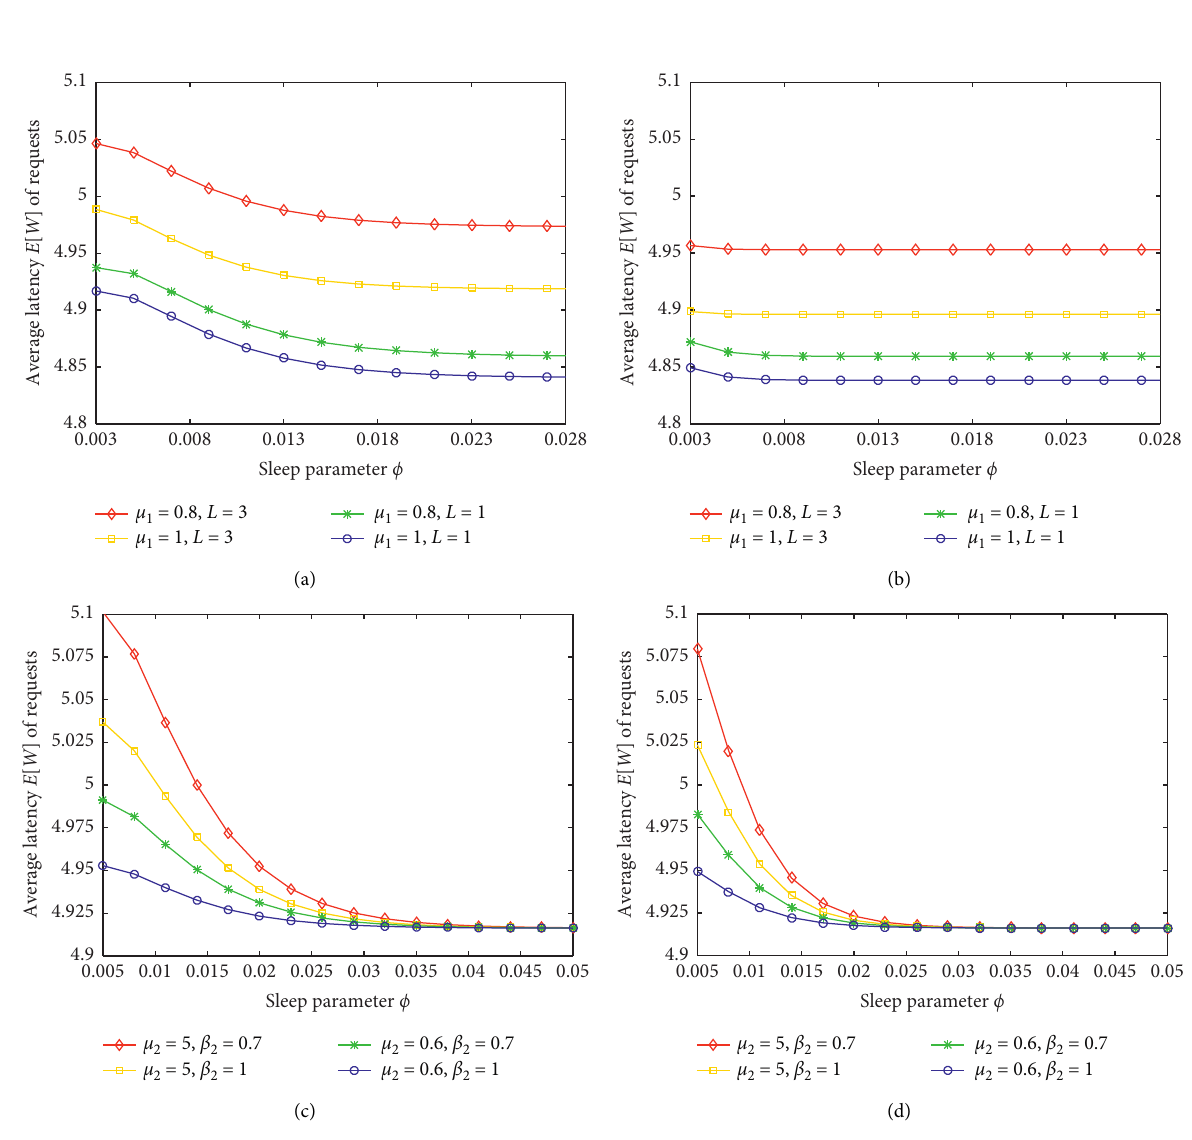
Figure 2: Average latency E [ W ] of requests vs. sleep parameter ϕ . (a) n